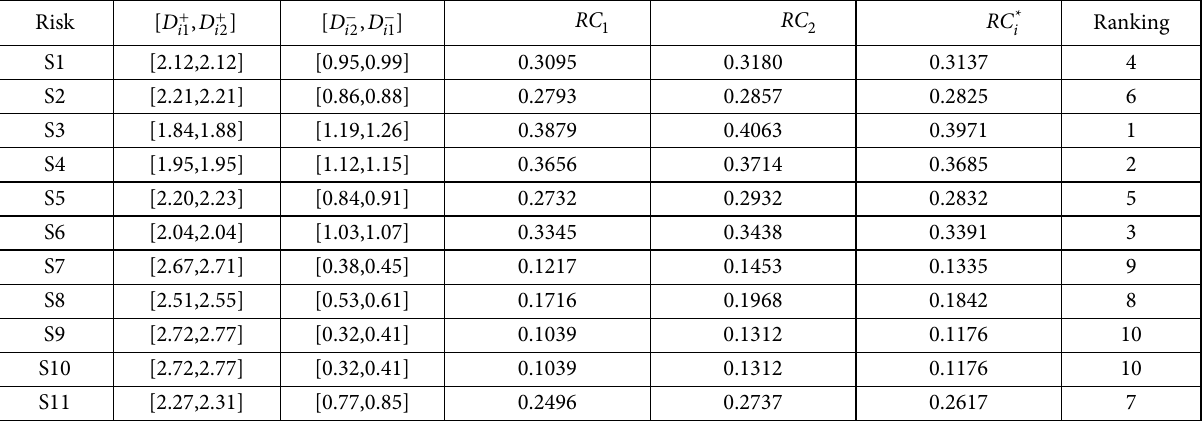
Table 7. Final ranking of the risk factors